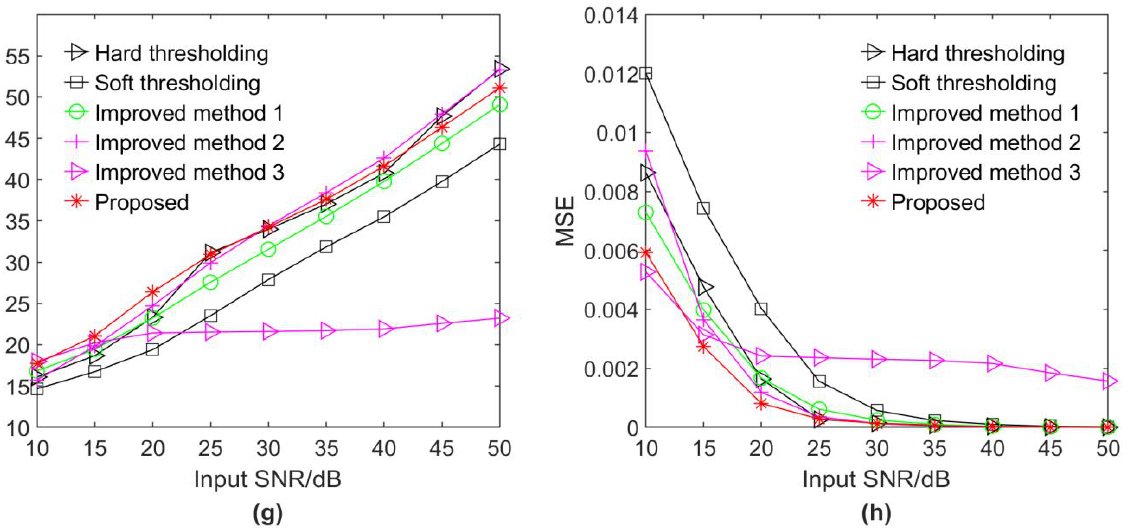
Figure 8. SNR and MSE comparisons for various types of signals following denoising with various denoising algorithms. ( a ) Output SNR of interruption; ( b ) MSE of interruption; ( c ) output SNR of impulsive transient; ( d ) MSE of impulsive transient; ( e ) output SNR of oscillatory transient; ( f ) MSE of oscillatory transient; ( g ) output SNR of harmonics with sag; ( h ) MSE of harmonics with sag.